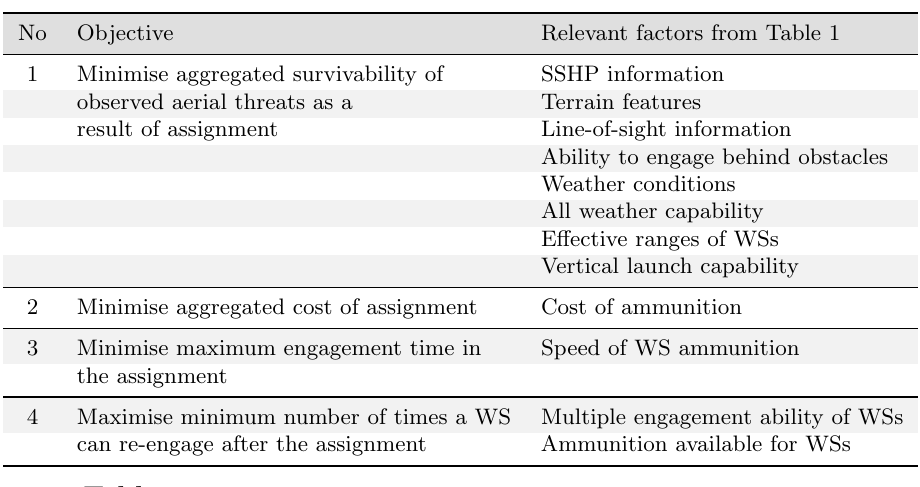
Table 2: WA objectives derived from the list of factors in Table